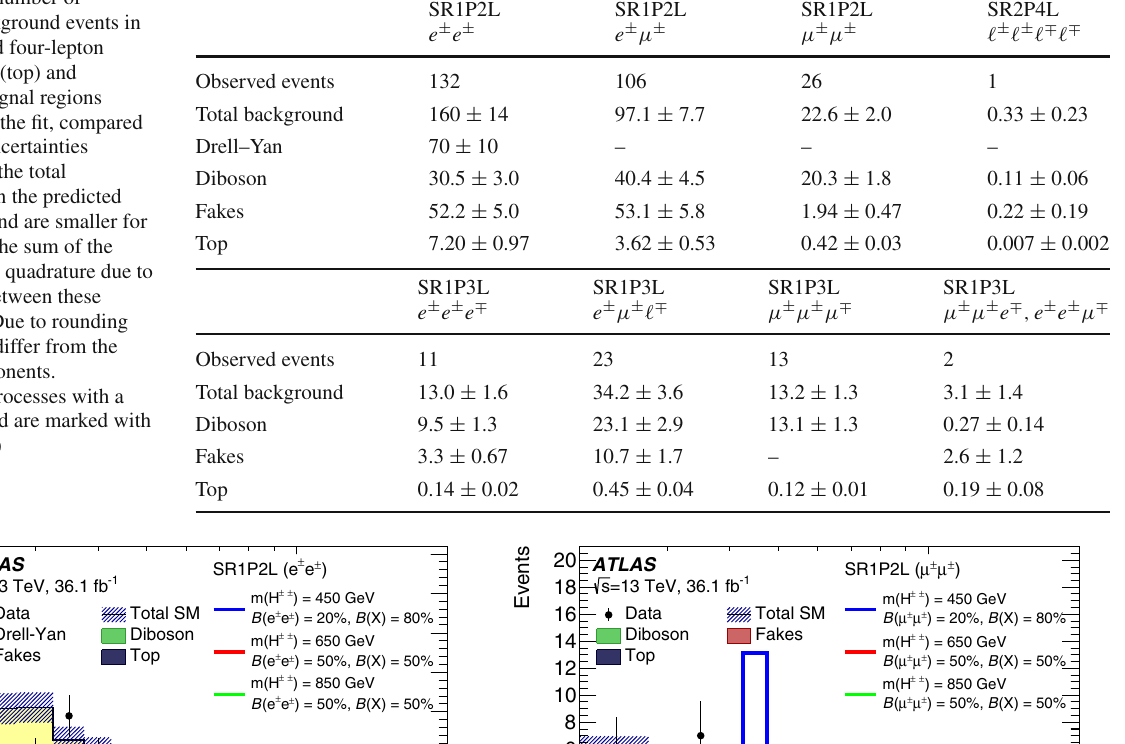
Table 7 The number of predicted background events in two-lepton and four-lepton signal regions (top) and three-lepton signal regions (bottom) after the fit, compared to the data. Uncertainties correspond to the total uncertainties in the predicted event yields, and are smaller for the total than the sum of the components in quadrature due to correlations between these components. Due to rounding the totals can differ from the sums of components. Background processes with a negligible yield are marked with the en dash (–)